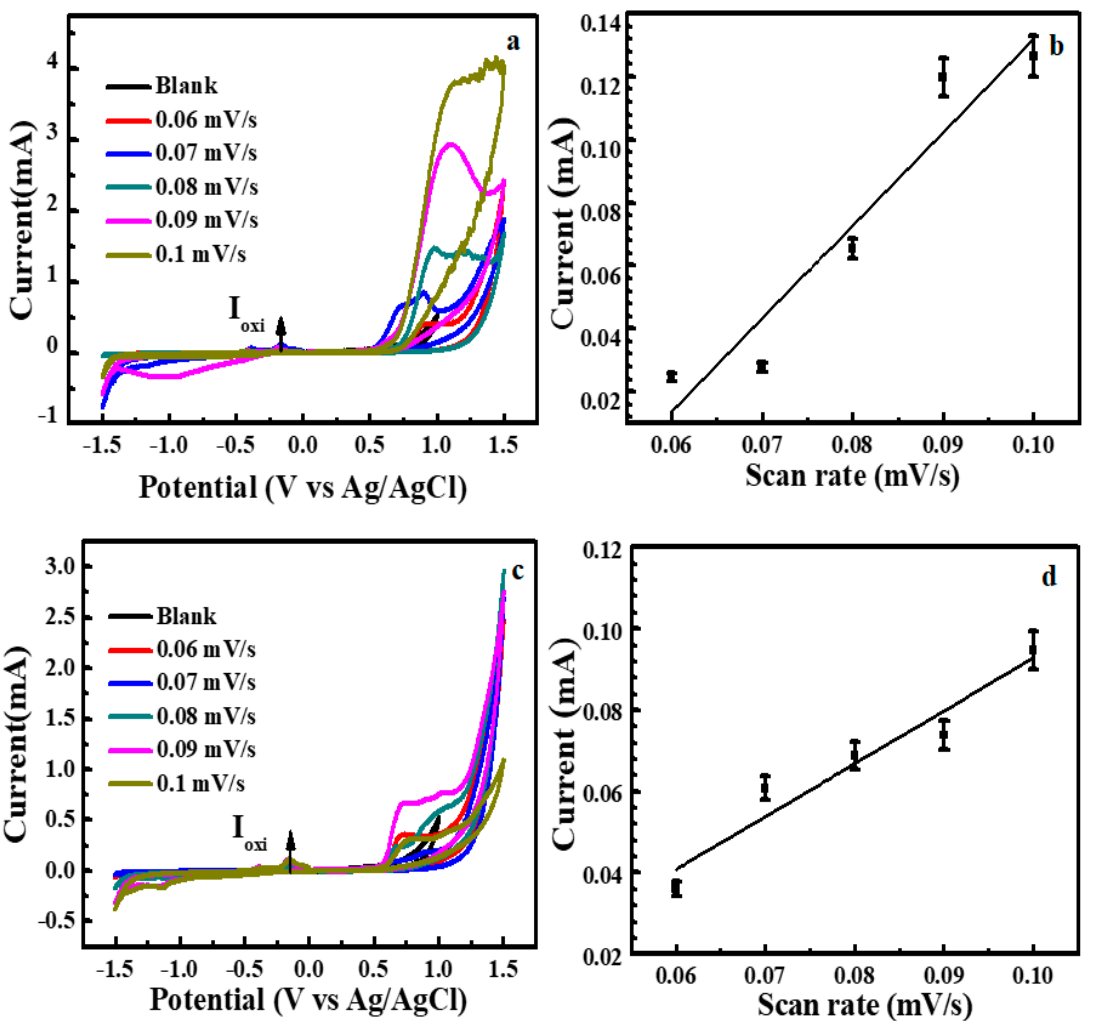
Figure 6. Effect of scan rate on electrochemical performance of Cu 2 O-Co 3 O 4 /CN composite synthesized ( a ) at 400 °C, ( b ) its calibration curve; ( c ) at 500 °C, and ( d ) its calibration curve obtained at scan rates in 1M KOH.